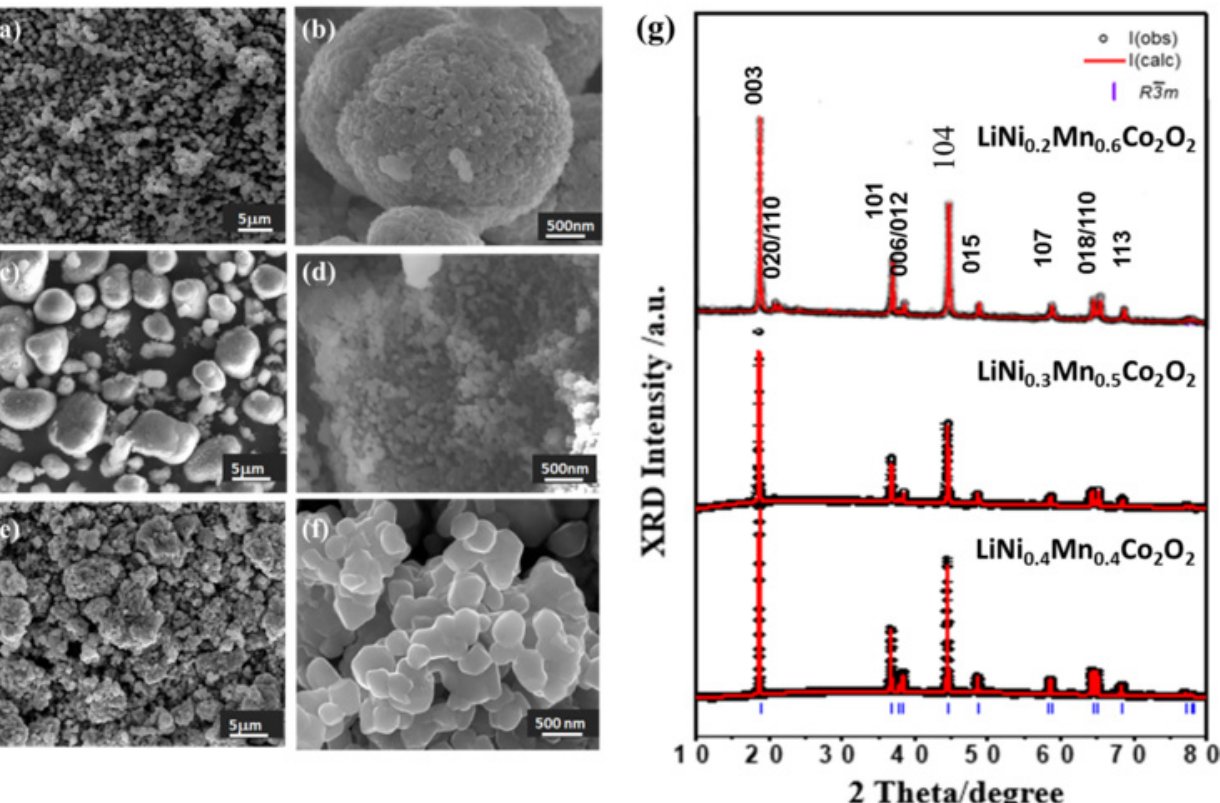
Figure 2. Scanning electron micrographs ( a , c , e ) and high-magnification scanning electron micro- graphs ( b , d , f ) for NMC262, NMC352 and NMC442, respectively. ( g ) XRD Rietveld analysis for NMC262, NMC352 and NMC442. XRD Rietveld analysis for NMC262, NMC352 and NMC442 is shown in Figure 2g. The black circles represent the observed XRD intensity, while the red line marks the calculated intensity. The low reliability factor (R wp (NMC262) = 1.90%, R wp (NMC352) =2.95% and R wp (NMC442) = 3.53%) obtained for these NMC compositions, along with the reduced